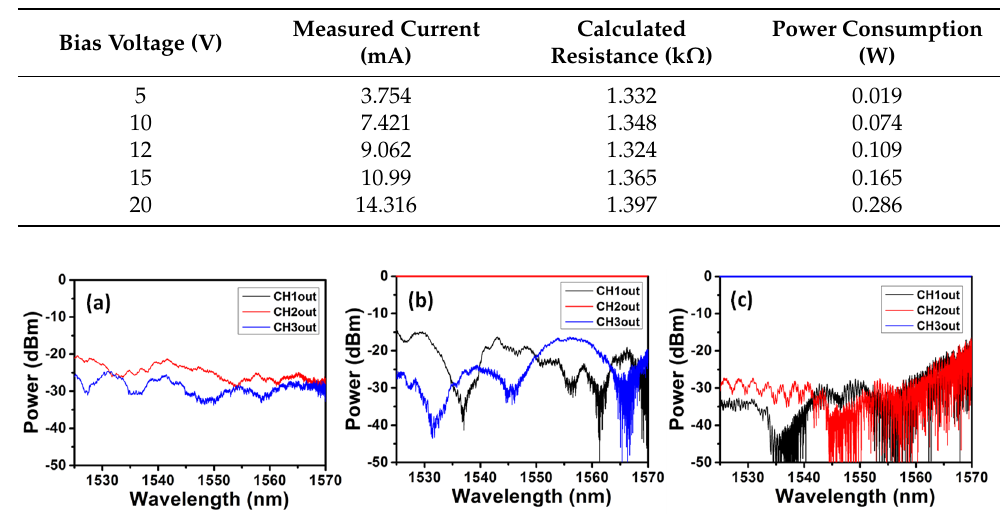
Figure 6. Measured normalized crosstalk observed at different output ports of the 3 × 3 switch when inputted at ( a ) CH1, ( b ) CH2 and ( c )